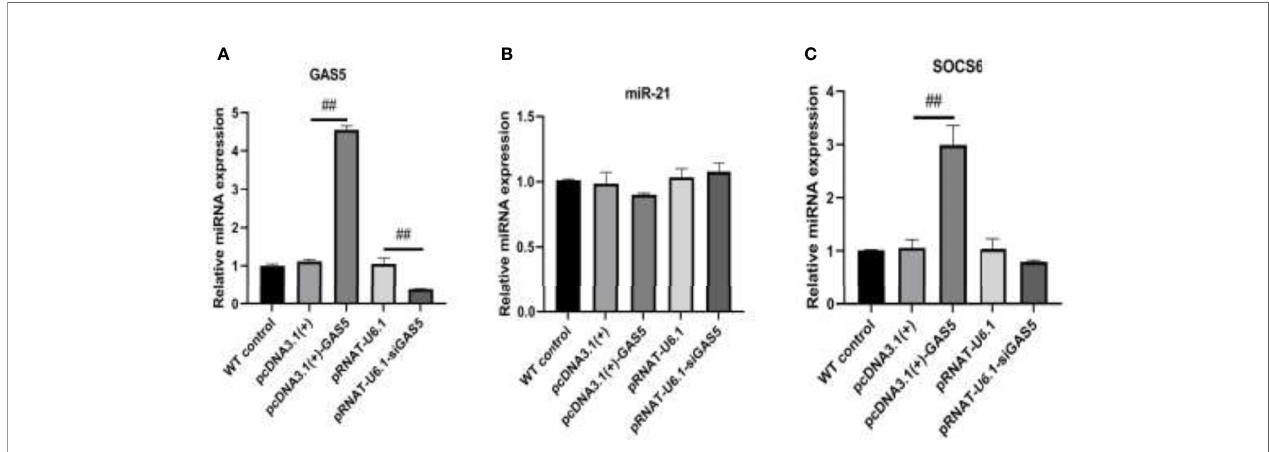
FIGURE 5 | The expression of GAS5/miR-21/SOCS6 is detected after overexpression and interference with GAS5. (A) The expression level of GAS5. (B) The expression level of miR-21. (C) The expression level of SOCS6. Statistical signi fi cance was determined by the Student ’ s t -test ( ## p < 0.01).